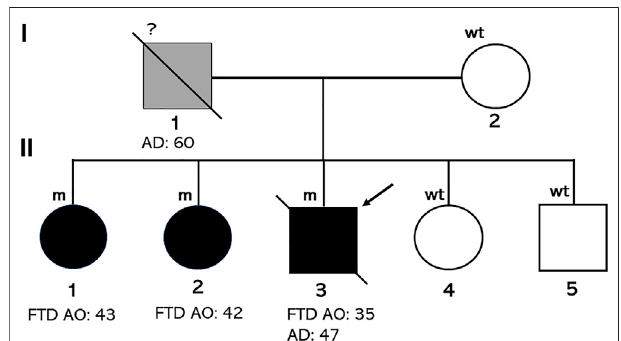
FIGURE 2 | Pedigree of the family. Individuals affected by FTD carrying the D395A mutation are indicated with black diamonds (male) or circle (females). Thearrow indicates theproband. Age at onset(AO)or at death (AD) is